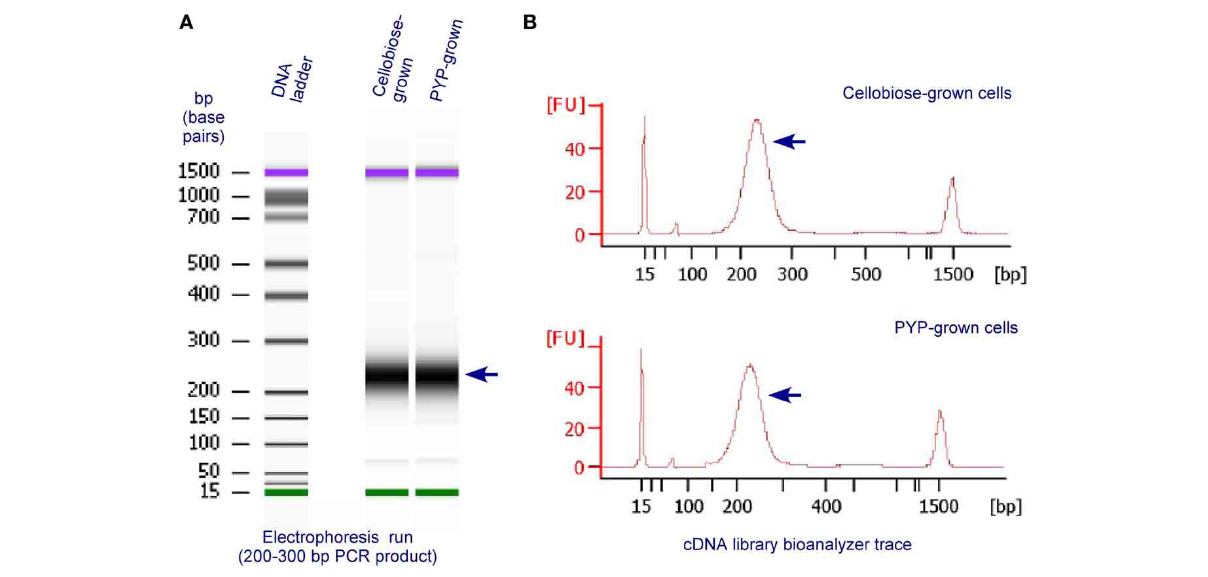
USA). The RNA-Seq cDNA libraries were prepared from RNA extracted from C. thermocellum cells grown on cellobiose or PYP. (A) Electrophoresis run of the cDNA libraries by the Bioanalyzer; (B) bioanalyzer trace of cDNA